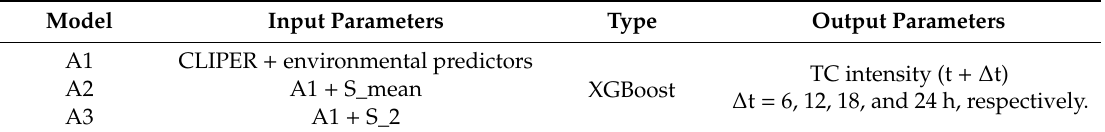
Table 5. Input and output parameters of the three prediction